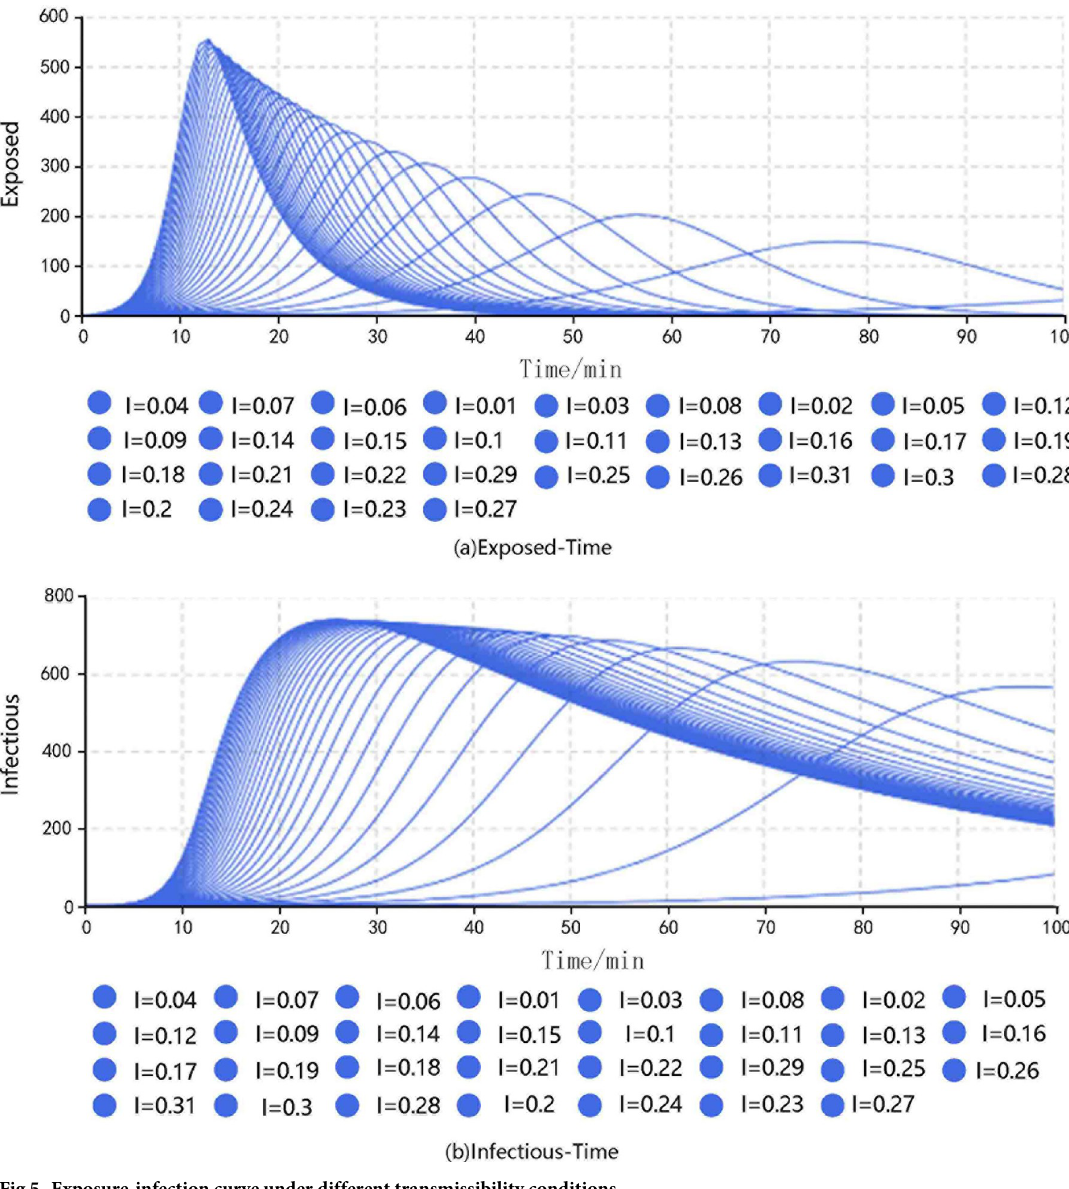
Fig 5. Exposure-infection curve under different transmissibility conditions.